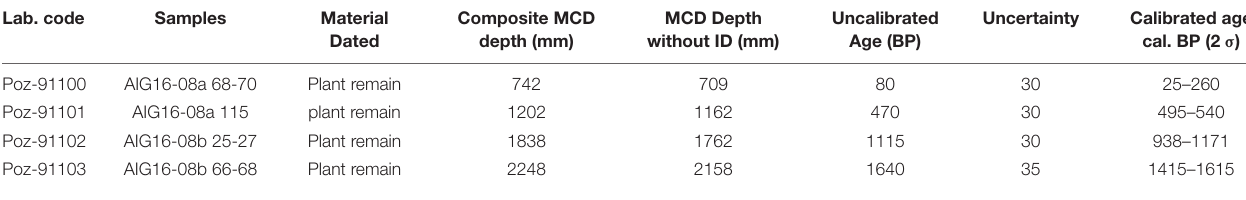
TABLE 1 | 14 C dates for Lake Aiguebelette related to AIG16 master core depth. Lab.